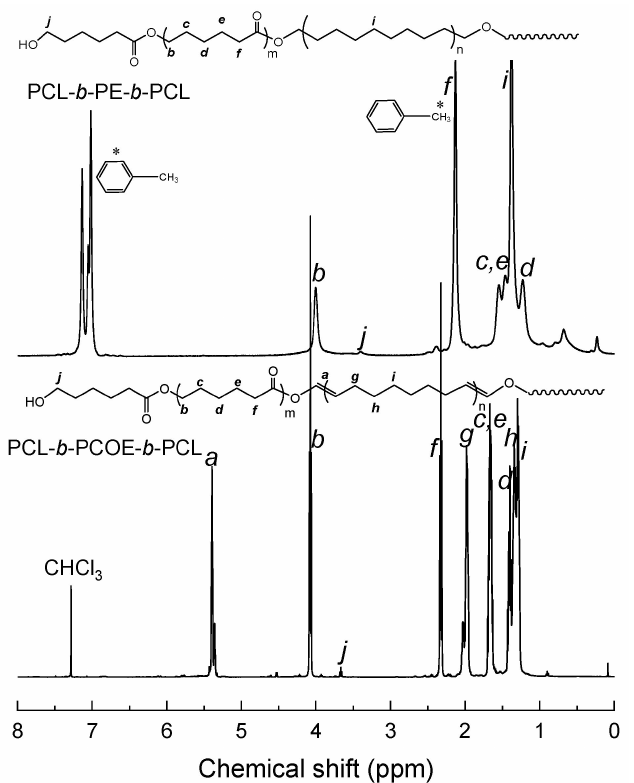
Figure 2. 1 H NMR spectra of triblock copolymers. Asterisk * peaks resulted from deuterium toluene, which was used to dissolve the